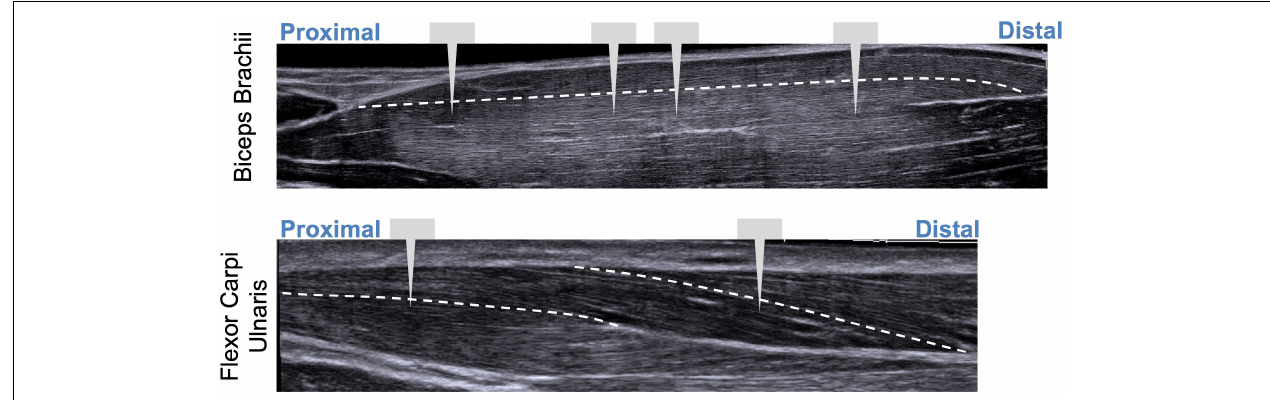
FIGURE 4 | Illustration showing extended field-of-view ultrasound images with approximate locations of probe insertions along the muscle. White dashed line represents fascicle paths.